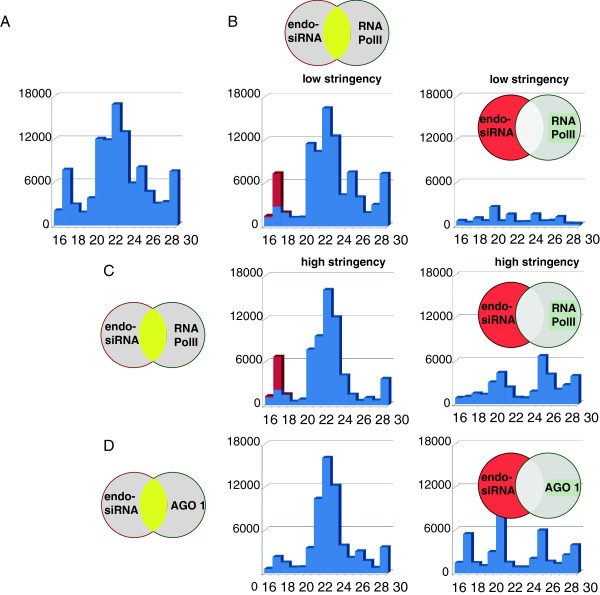
Length signature of endo-siRNAs that co-localize with RNAPII or co-precipitate with AGO 1. (A) Total endo-siRNA sample excluding reads that map to LPPR5, LYPD3 or TMEM25, as discussed in the text. (B) Endo-siRNA signature of all reads that do (left) or do not (right) co-localize with RNAPII as indicated by the Venn diagram. (C) Same as (B) but reads that mapped to regions with low RNAPII ocupancy (<1.5 percentile) were excluded, low stringency. (D) Endo-siRNA length distribution of reads that do (left) or do not (right) associate with AGO1. The rust-colored reads stem from a single gene, STAMBP.